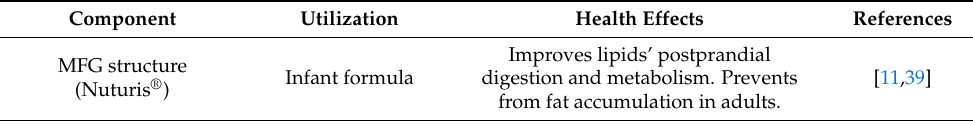
Table 1. Examining lipid breast milk components used in health applications, summary of evidences (clinical trials, cohort studies, and